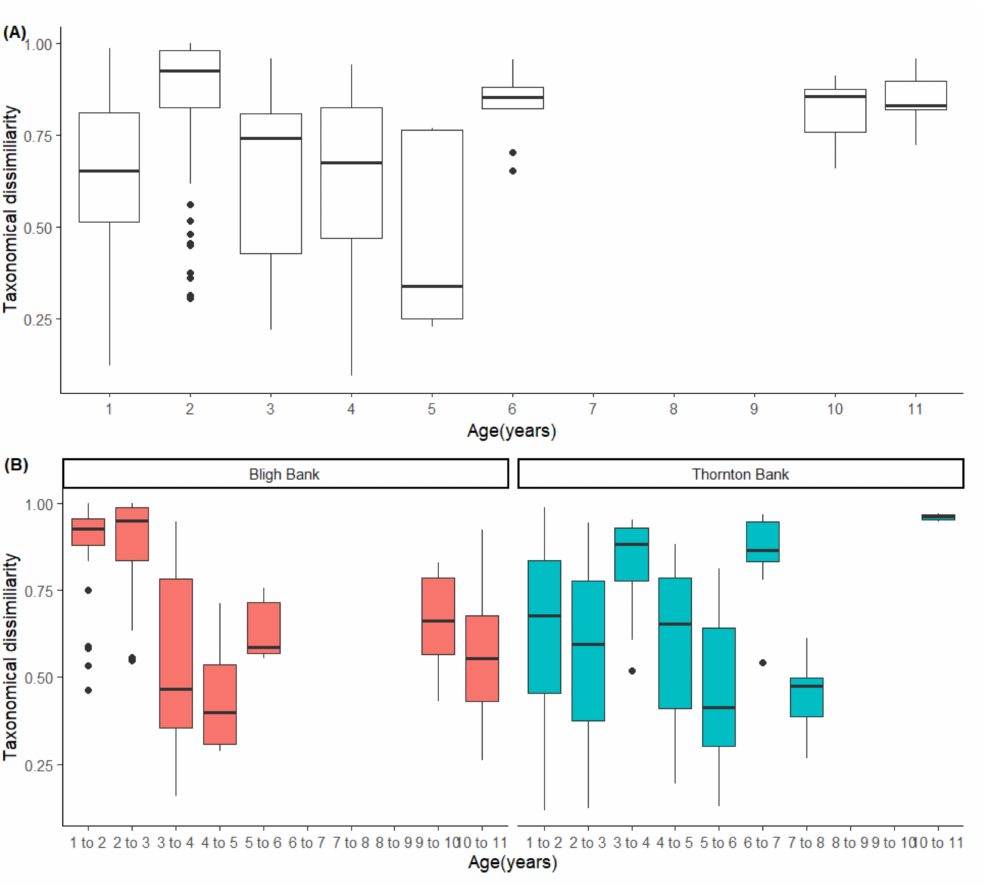
Figure 3. Temporal variation of taxonomic dissimilarity between ( A ) and within ( B ) the two offshore wind farms. The dissimilarity between the two wind farms increases, suggesting a divergence in community